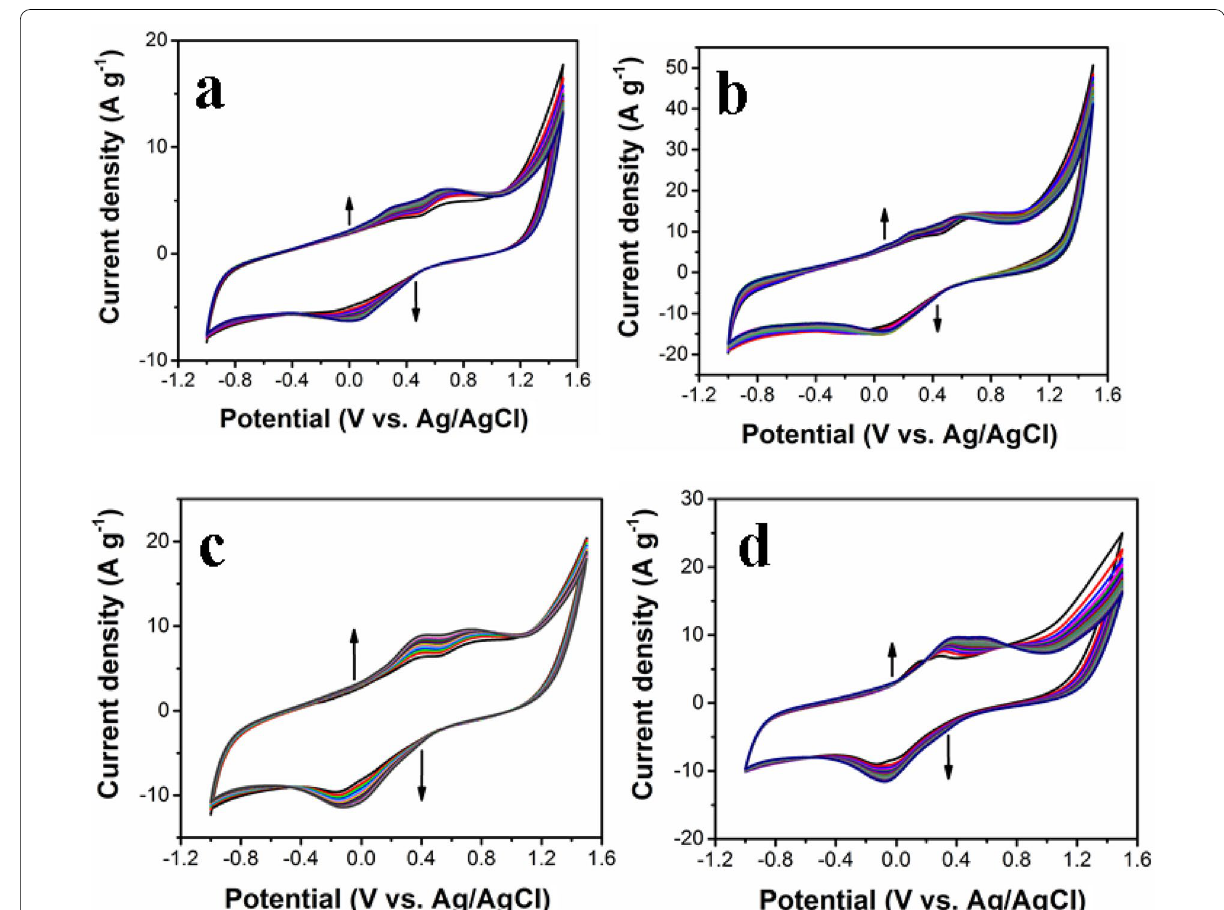
Fig. 1 CV curves of MB electropolymerization (50 cycles) for a 0.1 mM, b 0.2 mM, c 0.4 mM and d 1.0 mM MB